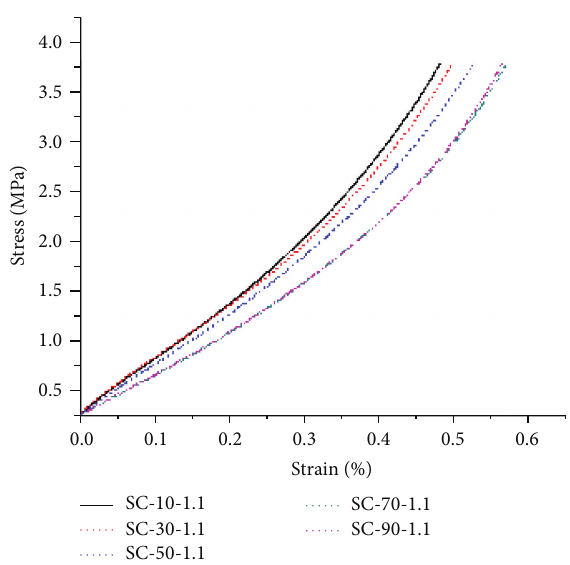
Figure 5: Compressive stress-strain curves for different gradation combinations.